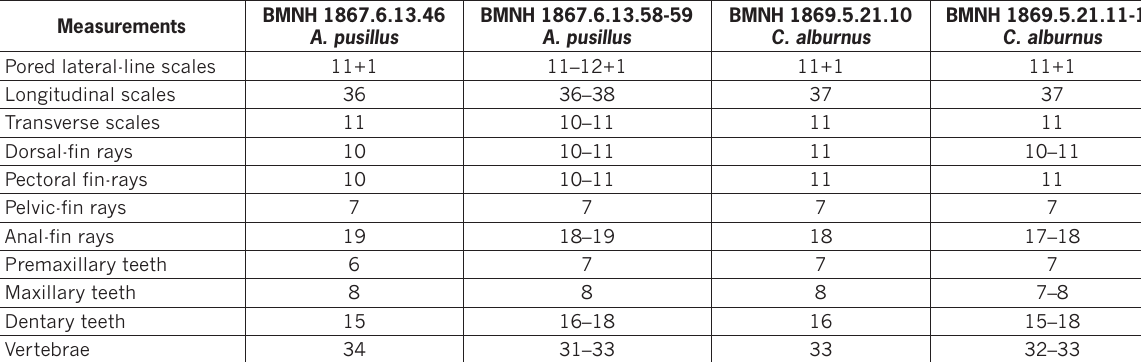
and Xeberos [Amazon River Basin, Peru], Mr.